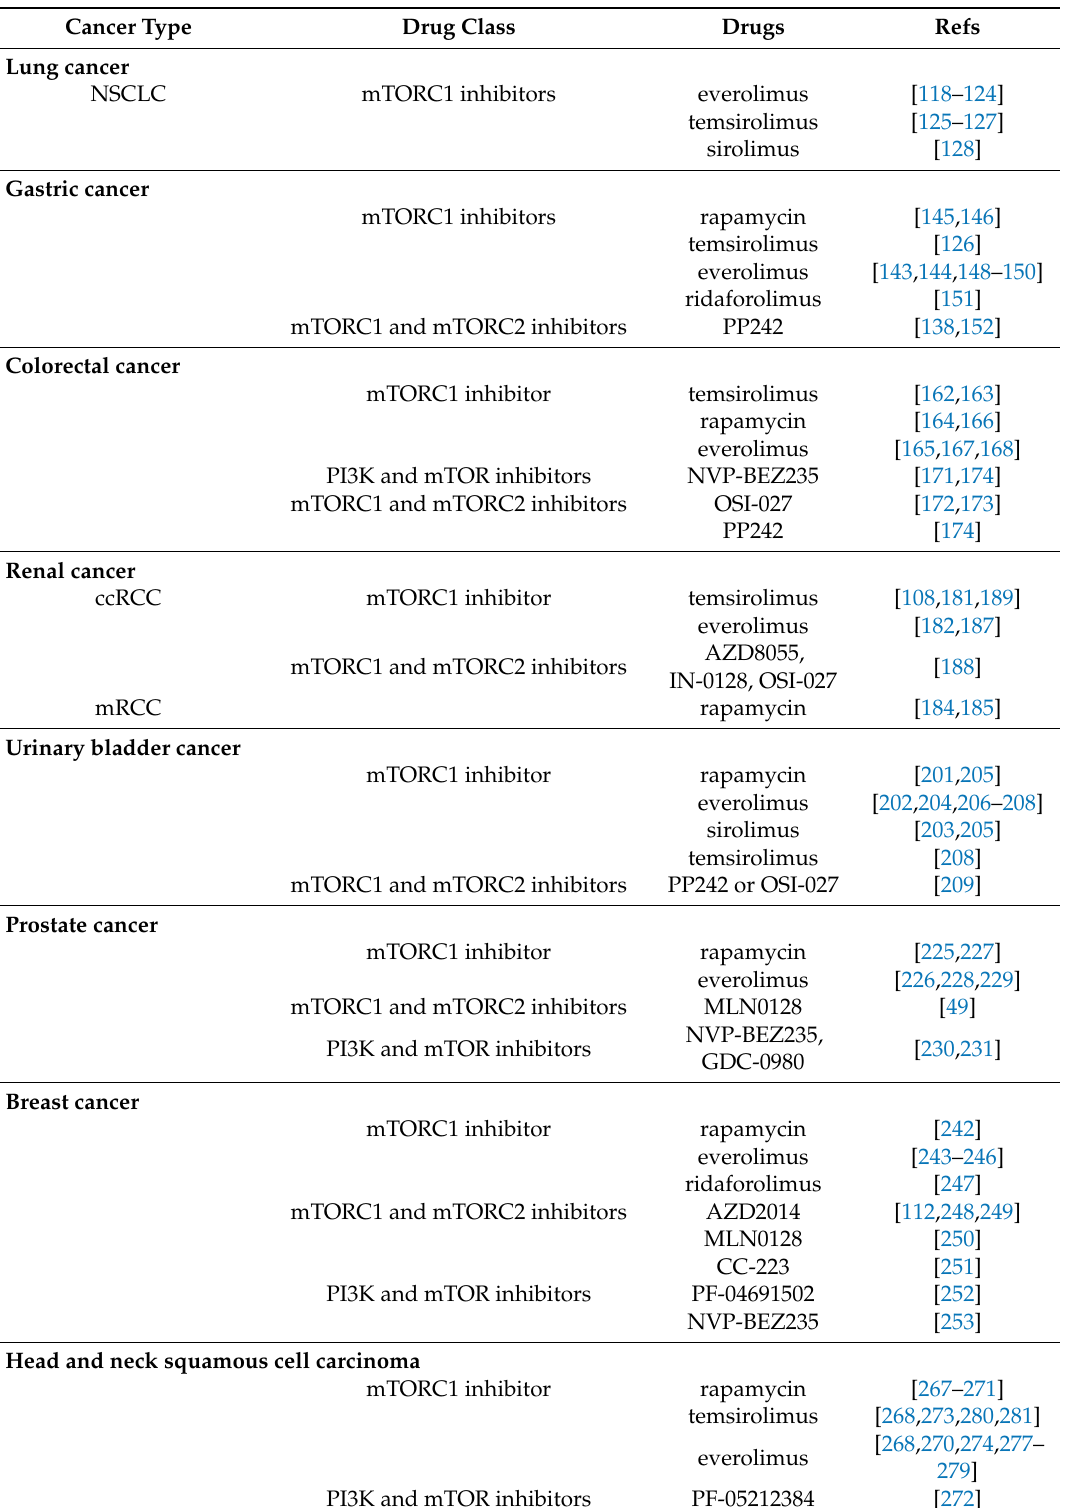
Table 2. mTOR inhibitors that are under preclinical and clinical trials in eight solid cancer types summerized in this